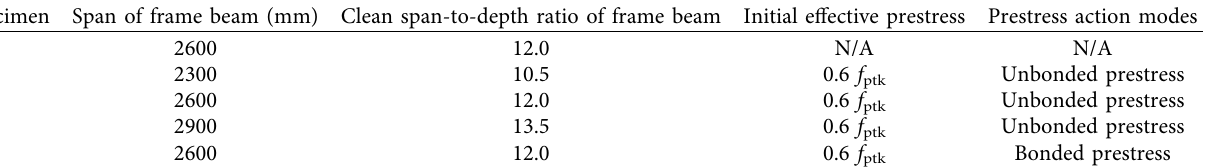
Figure 2: Dimensions and reinforcement of S1. Table 1: Design parameters of the specimens.